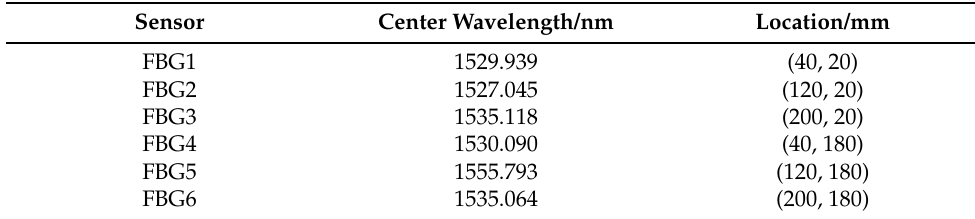
Table 1. Wavelength and position of the gratings.